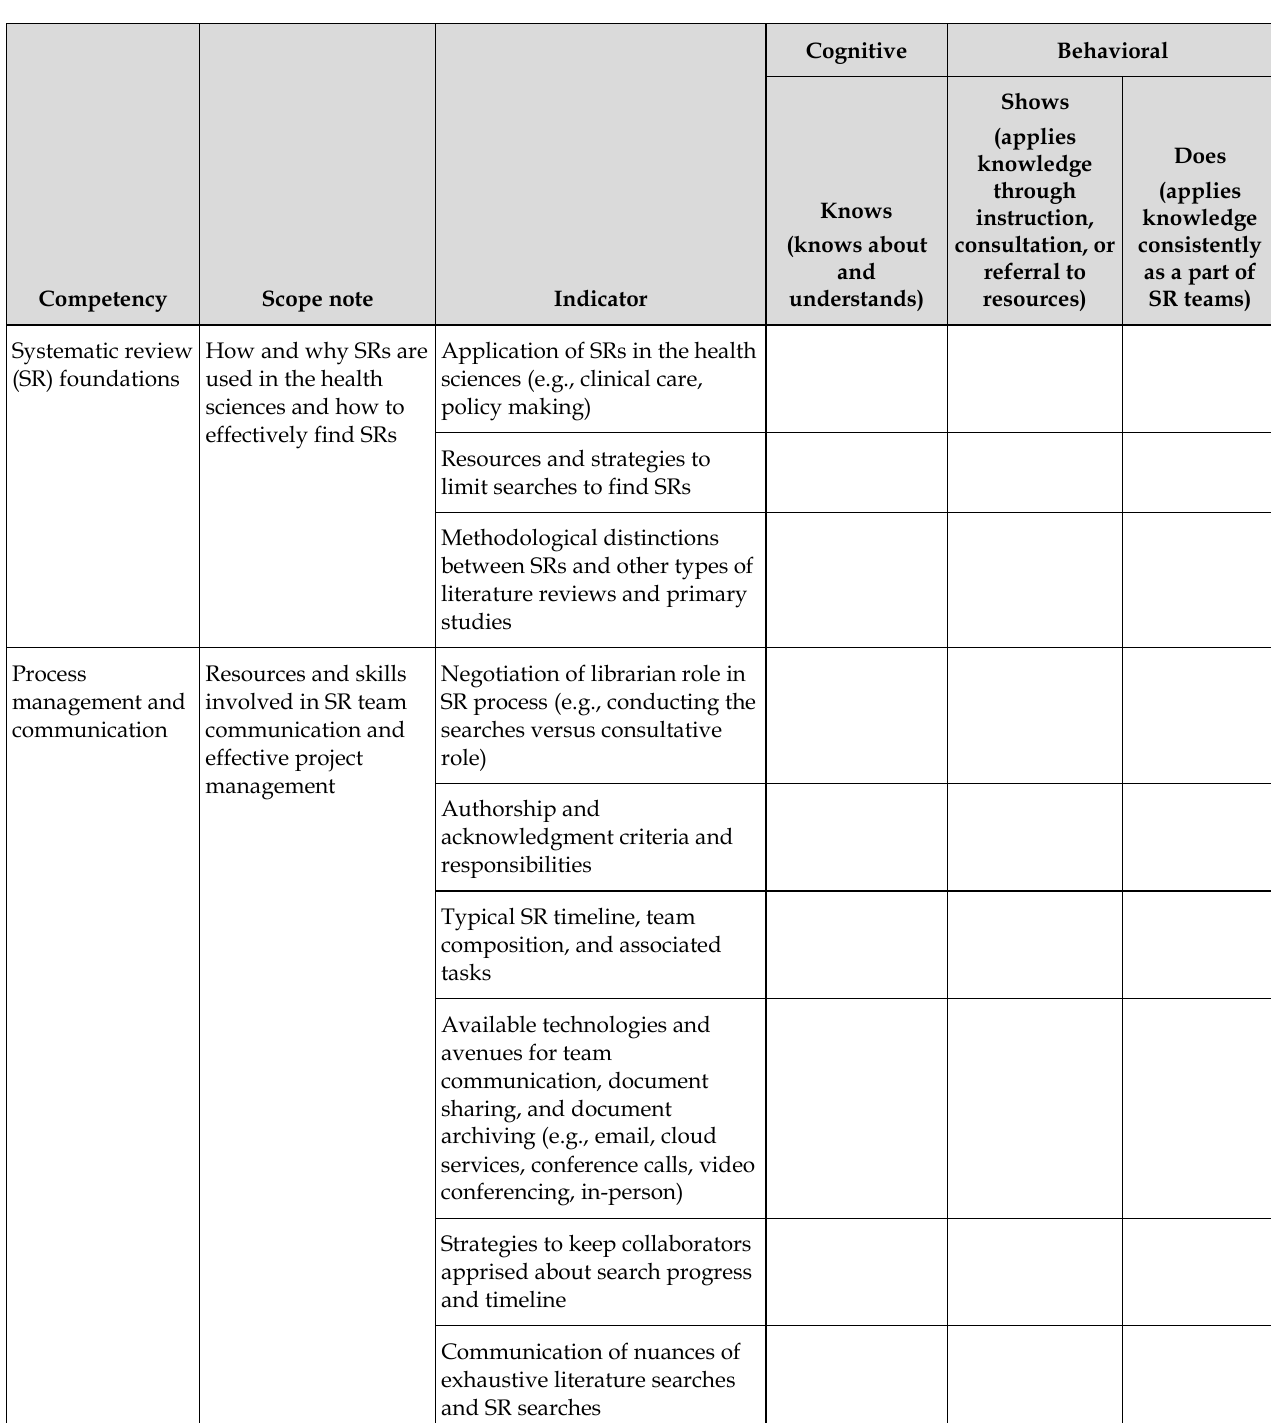
Table 1 Systematic Review Competencies